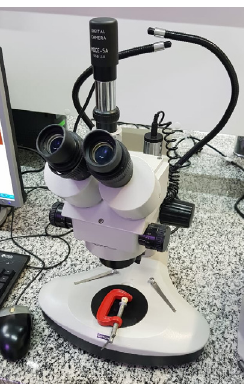
Figure 1. Crown adapted to the prepared dental unit and maintained in a standardized position during the analysis in a stereomicroscope